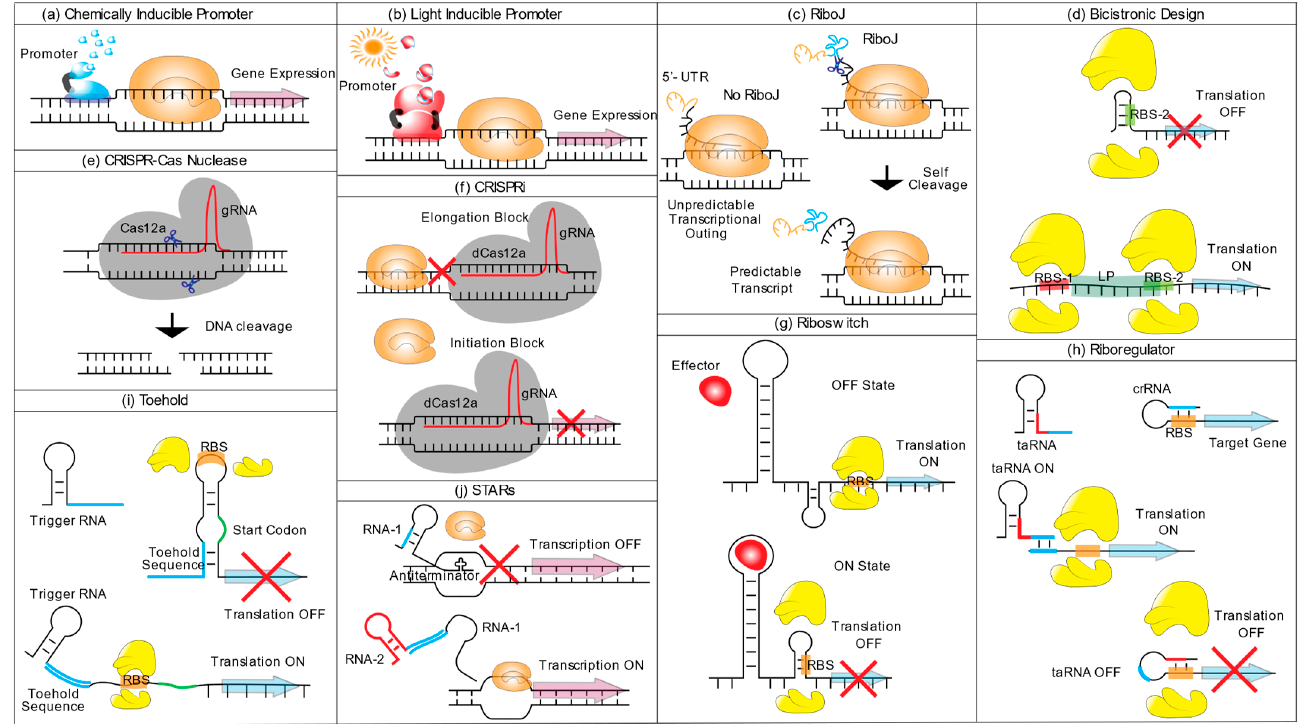
Figure 1. Schematic representation of synthetic biology tools available for cyanobacteria. ( a ) Chemically inducible promoter, upon binding of a small chemical inducer (blue shapes), the activator binds to the promoter leading to transcription activation (violet arrow) through the activity of RNA polymerase II (orange shape). At the same time, a repressor dissociates from the DNA upon inducer binding (not shown). ( b ) Light inducible promoter, light-sensing proteins (red shapes) are (de)activated upon light induction (red sun) and induce a cascade that results in transcription activation (grey arrow) or repression. ( c ) RiboJ, the self-cleavage activity of RiboJ (blue line), cleaves the variable 5 ′ -UTR sequence upstream of the ribozyme (orange line), leaving a shorter mRNA (black) with standardized 5 ′ -UTR ( d ) Bicistronic design; to avoid translation obstruction through RNA secondary structures of the RBS (RBS-2) (upper figure), a short leader peptide (LP) sequence with its own RBS (RBS-1) is placed upstream of the GOI. During translation of LP, the helicase activity of the ribosome resolves possible RNA secondary structures present in the RBS-2, embedded in the LP region, permitting translation of the downstream gene. ( e ) CRISPR-Cas Nuclease, Cas12a nuclease (grey shape) identifies the target sequence based on complementarity to gRNA (red line) and cleaves the complementary DNA strand, creating staggered ends. ( f ) CRISPRi, guided by a gRNA, an inactive version of Cas12a, dCas12a, targets a specific gene and obstructs the transcription by interrupting RNA polymerase activity either by binding to an exonic region (Elongation block) or the promoter region (Initiation block). ( g ) Riboswitch, the presence or absence of a ligand effector defines the occurrence of translation and, therefore, the ON/OFF gene expression switch. In the absence of the ligand, the ribosome binds the RBS and initiates translation (Translation ON). In the presence of the effector, it hybridizes with the RNA leading to a conformational change that renders the RBS inaccessible to the ribosome and impedes translation (Translation OFF). ( h ) A Ribo-regulator is composed of a trans-activating RNA (taRNA) and a cis-repressed RNA (crRNA). When expressed alone, the crRNA is present in a conformation that precludes the RBS from binding to the ribosome (taRNA OFF). The expression of a taRNA (taRNA ON), containing a region complementary to the 5 ′ of the crRNA (coloured in blue), binds to the crRNA, restricting it to a conformational change that makes the RBS accessible for ribosome binding. ( i ) Toehold switch, the toehold RNA structure, is located upstream of the translation start site (TSS, coloured in red) and the toehold hairpin structure renders the RBS inaccessible to the ribosome, precluding the initiation of the translation. A second RNA molecule (trigger RNA), containing a sequence complementary to the toehold 5 ′ sequence of the toehold RNA structure (coloured in blue), binds to and stretches the toehold structure and frees up the RBS, allowing translation initiation. ( j ) Small transcription activating RNAs (STARs), an RNA molecule (RNA-1) containing an anti-terminator sequence, hybridizes upstream of a target gene. The presence of the anti-terminator forces the RNA